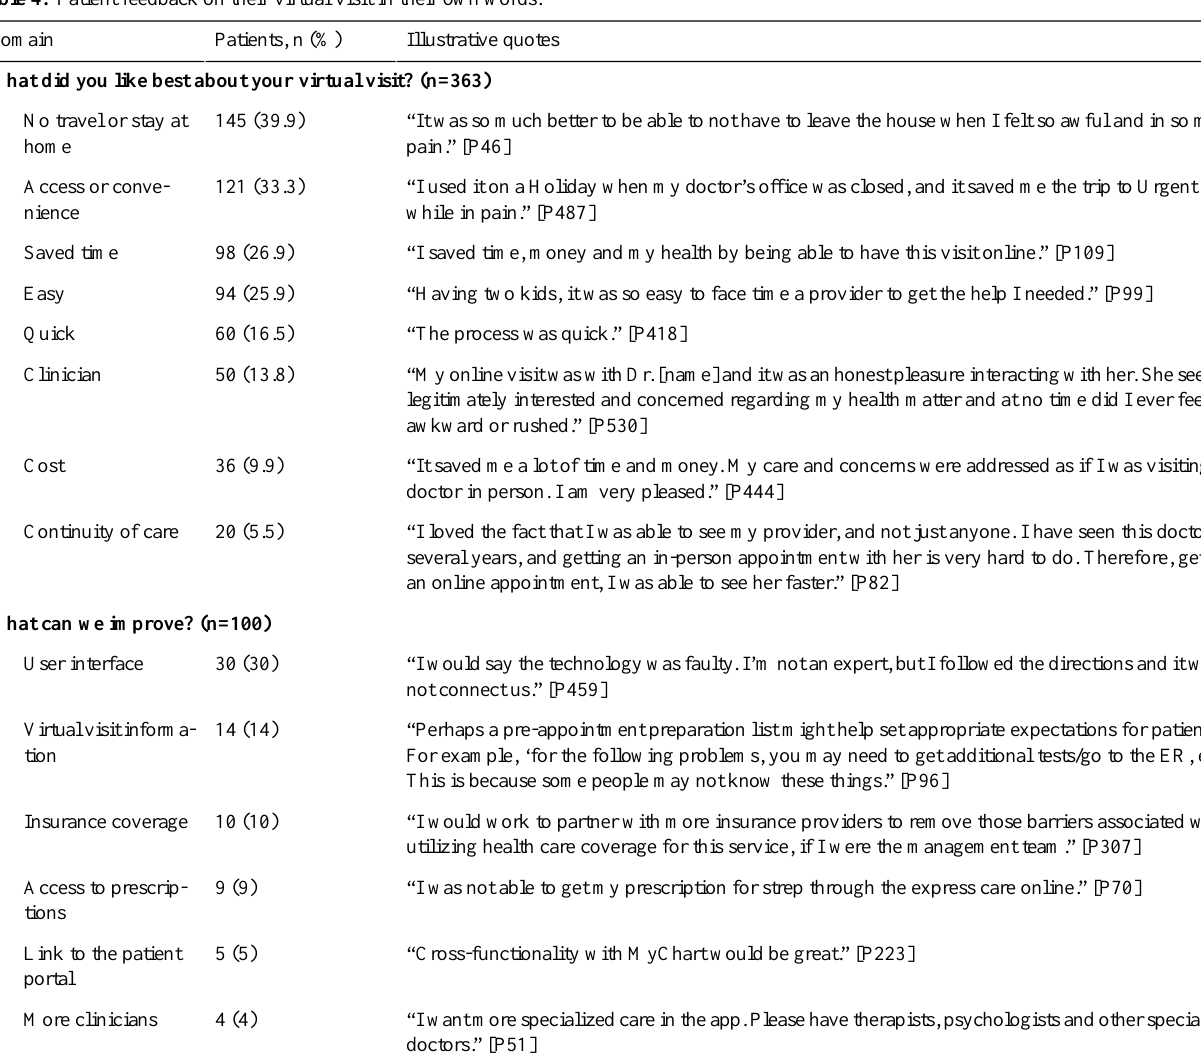
Table 4. Patient feedback on their virtual visit in their own